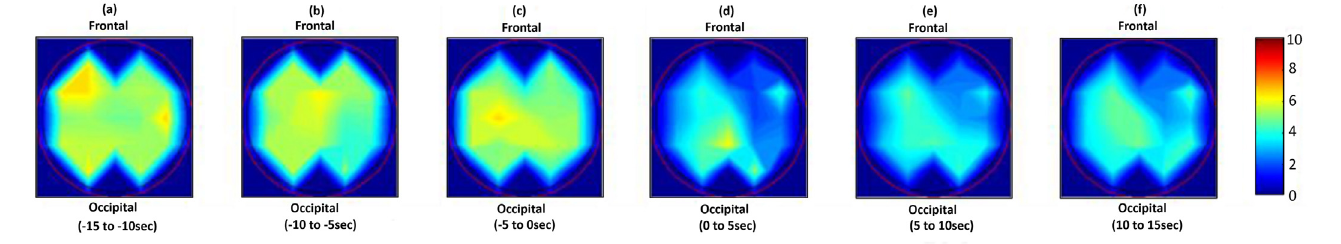
Fig 6. The variations of complexity index (CI) from epoch a to f in patient 1. Each epoch represented mean CI value calculated from 5 sec EEG data points from the pre-ictal state to the ictal state. Changes in mean CI were more prominent over the frontal and central areas during ictal state. The top of the figure was the front of the head and the bottom of the figure was the occipital area of the head. Blue color represented low CI value while red color represented high CI